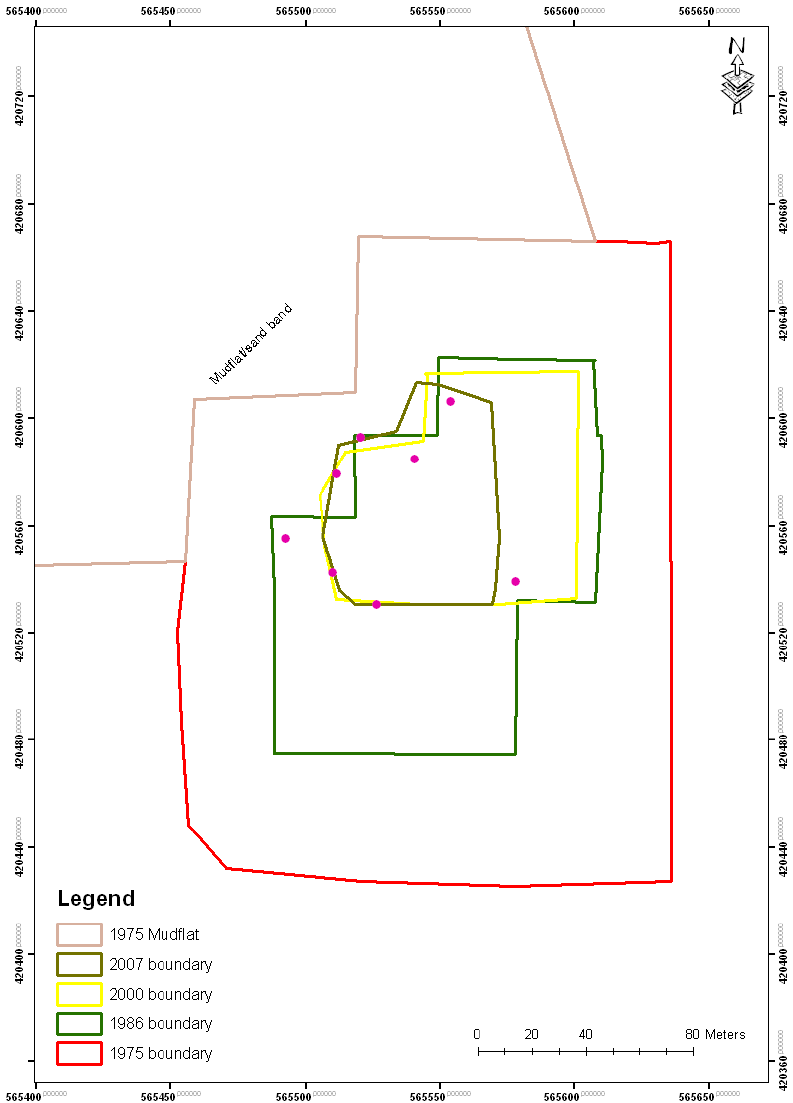
Figure 4. Seaward edge retreat of Kwelekwele Island from 1975 to